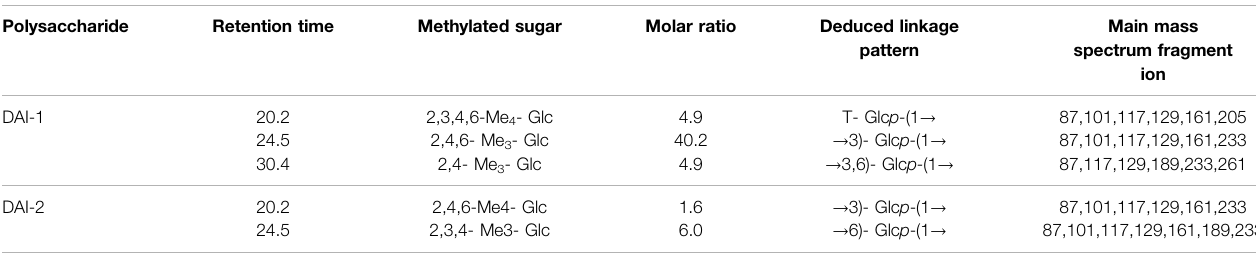
TABLE 2 | Methylation analysis data of DAI-1 and